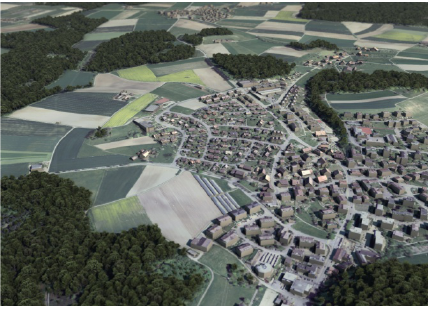
Fig. 9: Representation of